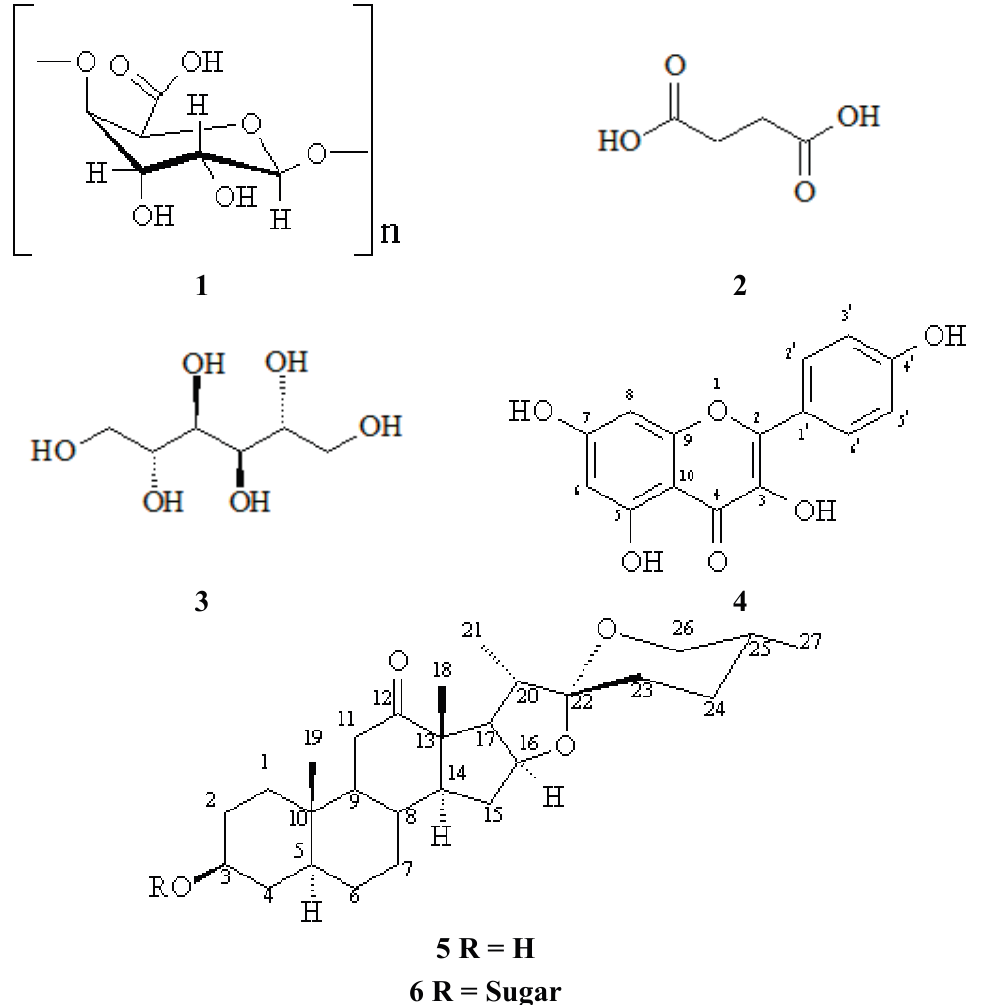
Figure 1. Chemical structure of the value-added compounds isolated from sisal waste: Pectin ( 1 ), Mannitol ( 2 ), Acid succinic ( 3 ), Kaempferol ( 4 ), Hecogenin ( 5 ) and Saponins ( 6